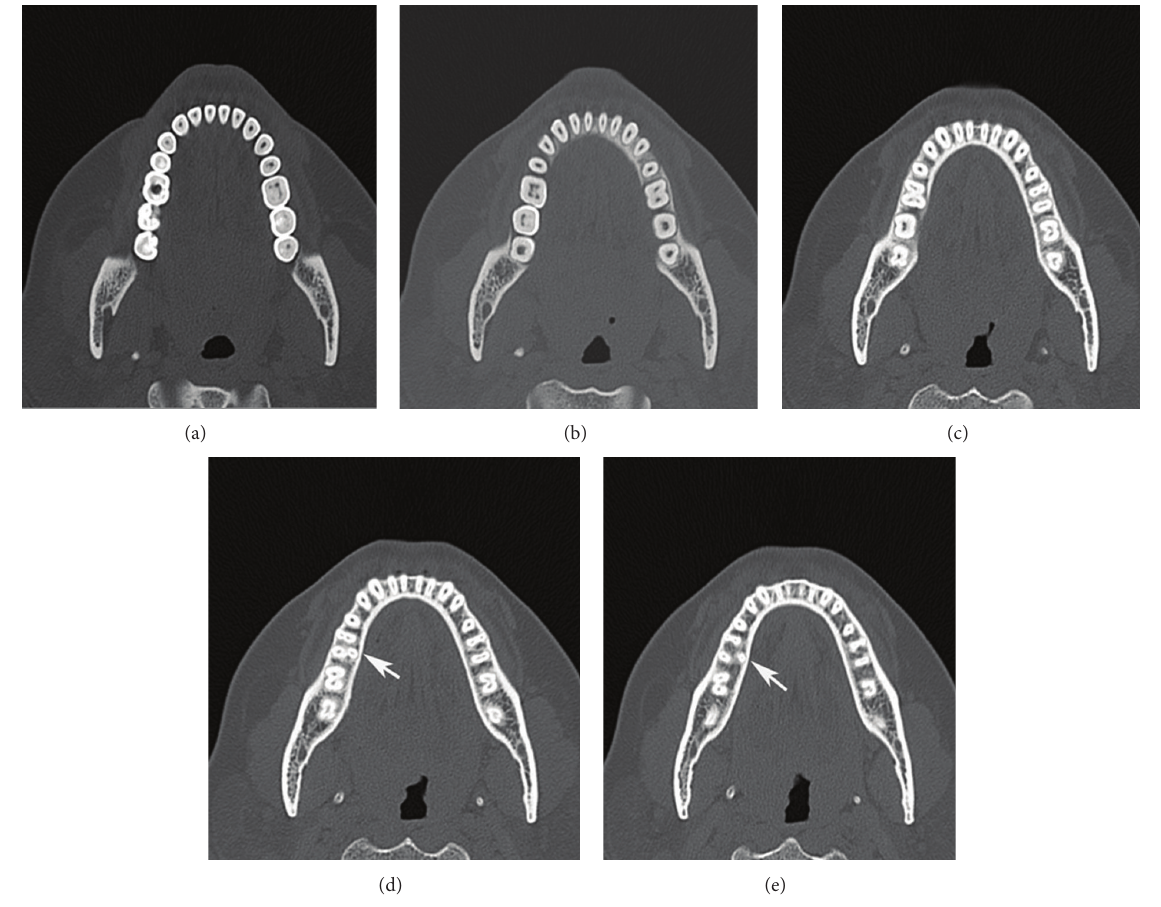
Figure 2: Axial CT scans of unilateral permanent three-rooted mandibular first molar. (a) Coronal section, (b) pulp-chamber section, (c) coronal-third root section, (d) mid-root section, and (e) apical-third root section. Arrows indicate extra DL roots.